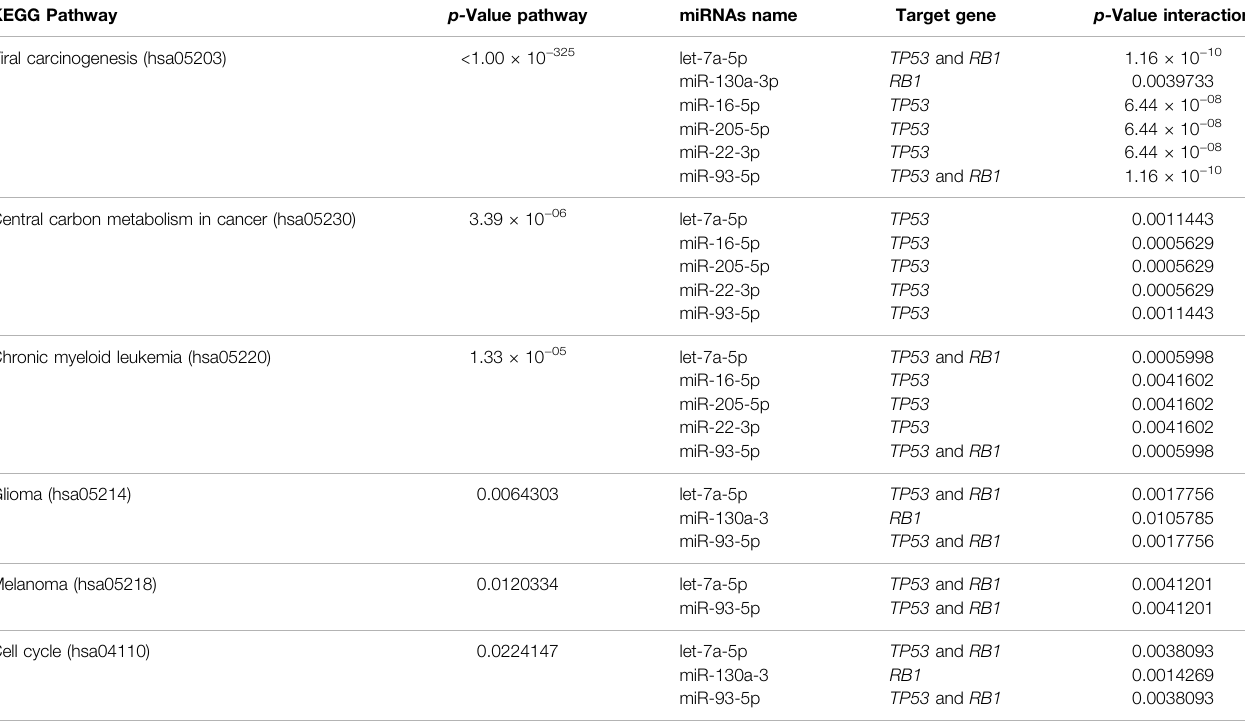
TABLE 4 | Top six molecular pathways involving overexpressed miRNAs targeting TP53 and RB1 genes. KEGG